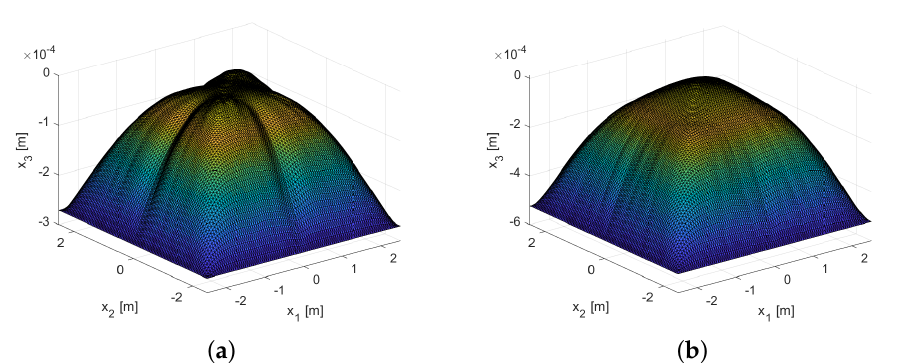
Figure 7. Membrane surfaces in equilibrium with the stress potentialof Figure 6: ( a ) r 0 = 0.5 and p 0 = 1; ( b ) r 0 = 1 and p 0 =